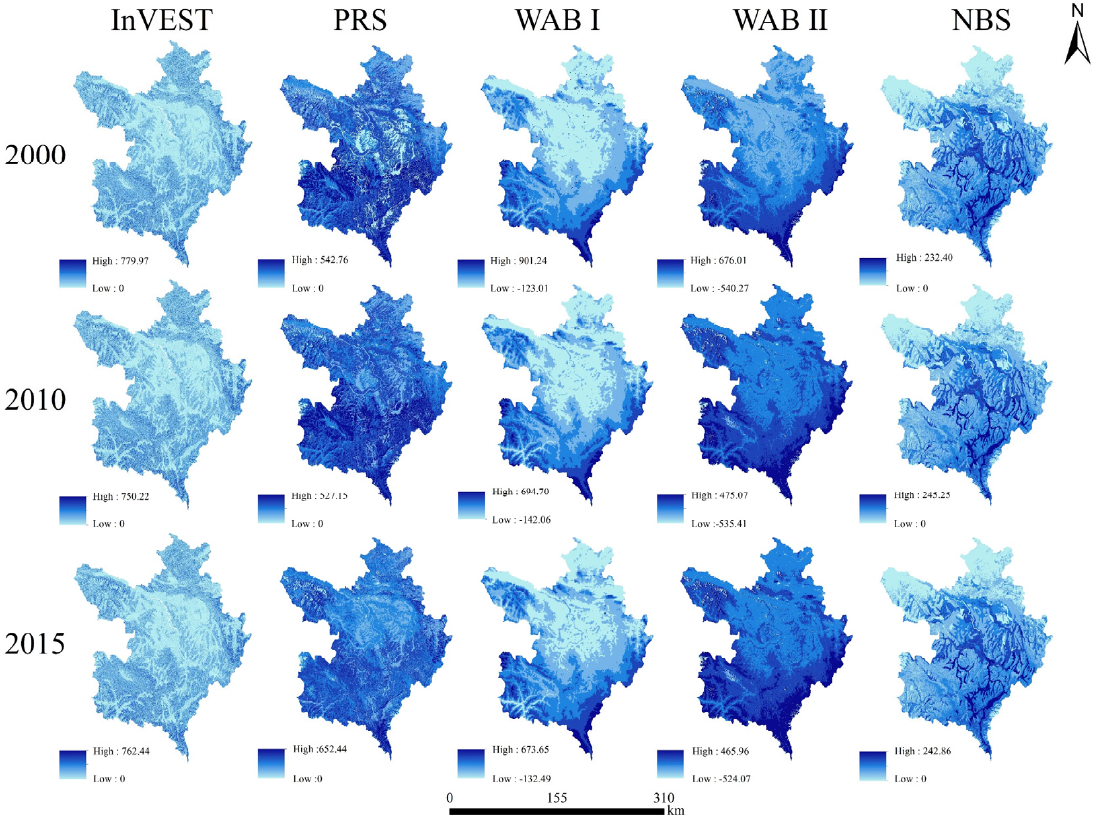
Figure 5. Spatial distribution of WR service by models from 2000 to 2015. The units for the InVEST, PRS, WAB I, and WAB II models are mm/grid and dimensionless for the NBS